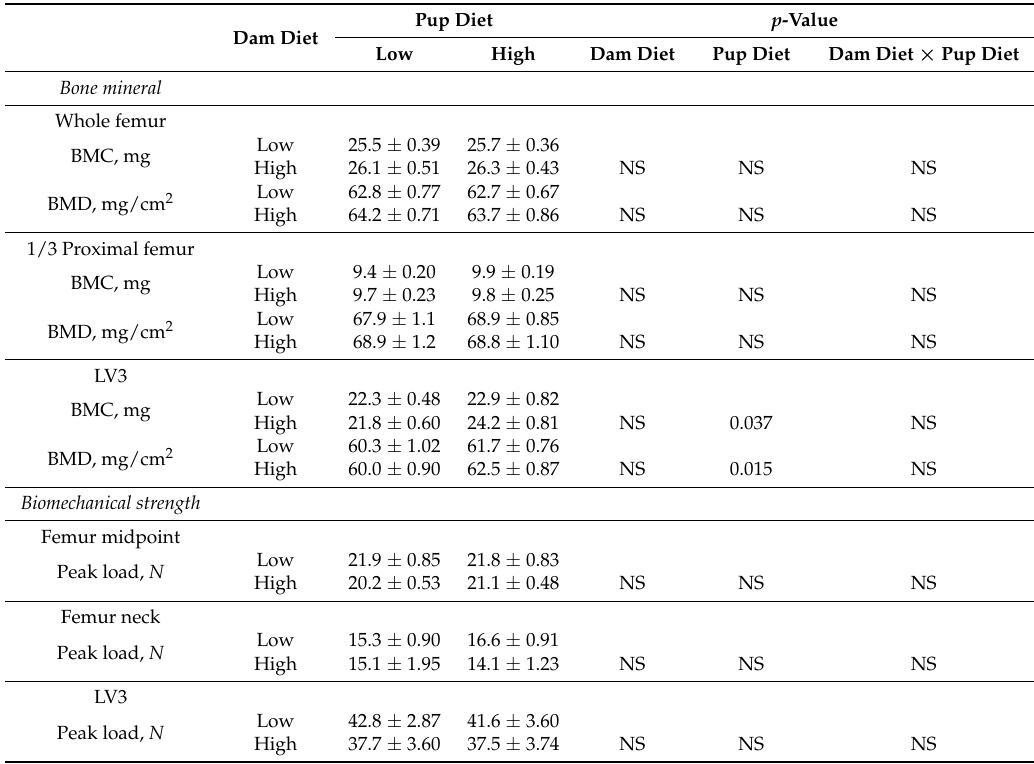
Table 1. Bone mineral and biomechanical strength properties of femurs and LV from female C57BL/6J mice a